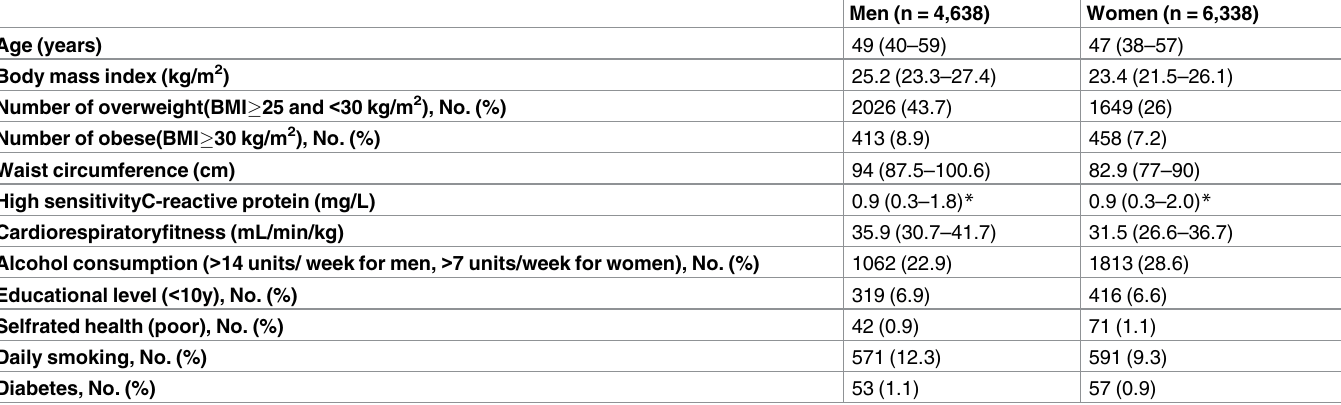
Table 1. Descriptivecharacteristics of the 10,976 participants from DANHES 2007–2008. Median(25 th -75 th percentiles) unless stated